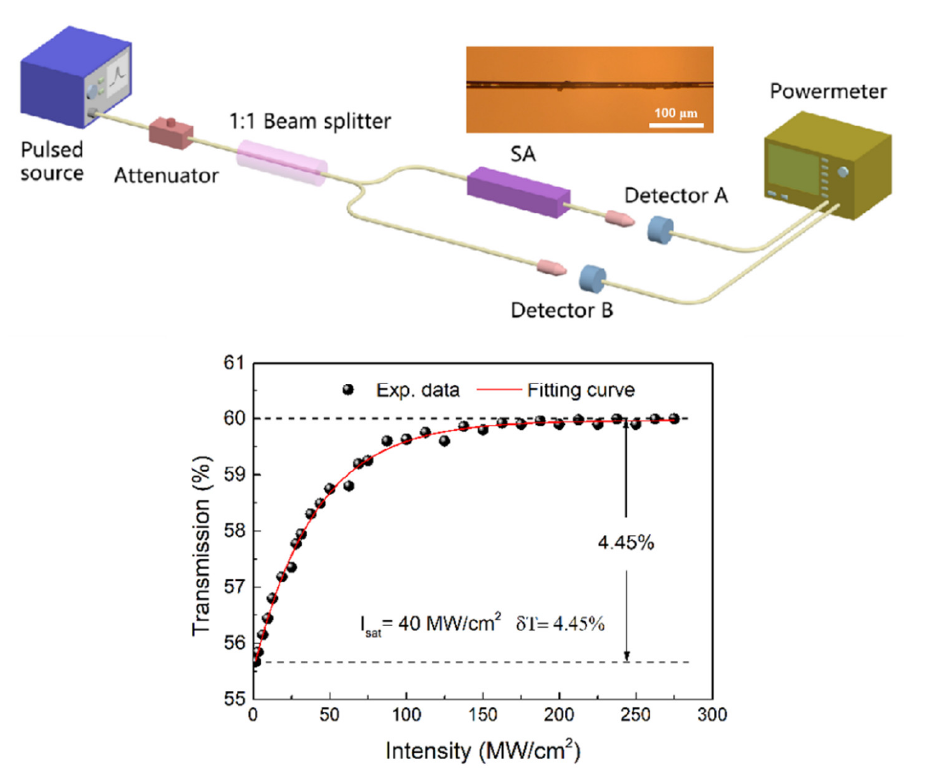
Figure 2. The experimental setup and the corresponding saturable absorption curve of the MoTe 2 - assisted microfiber device (inset: the photograph of the MoTe 2 device).